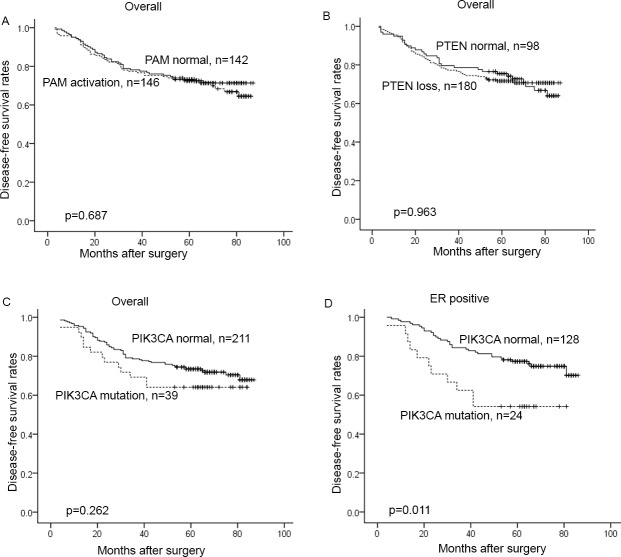
Correlation between PI3K/AKT/mTOR pathway alterations and prognosis by Kaplan–Meier survival analysis.A. PAM activation vs. normal PAM in all patients; B. PTEN loss vs. normal PTEN in all patients; C. mutant PIK3CA vs. normal PIK3CA in all patients; D. mutant PIK3CA vs. normal PIK3CA in ER positive patients.